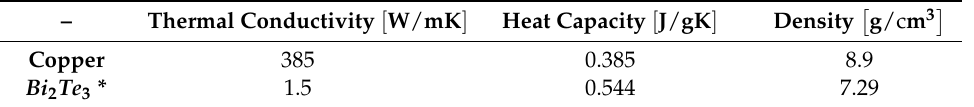
Table 5. Thermal properties of thermoelectric materials and solar collector.